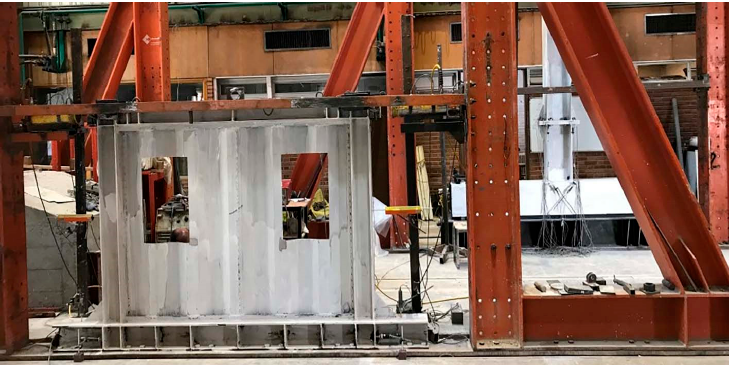
Figure 7. Test setup of specimen 2.